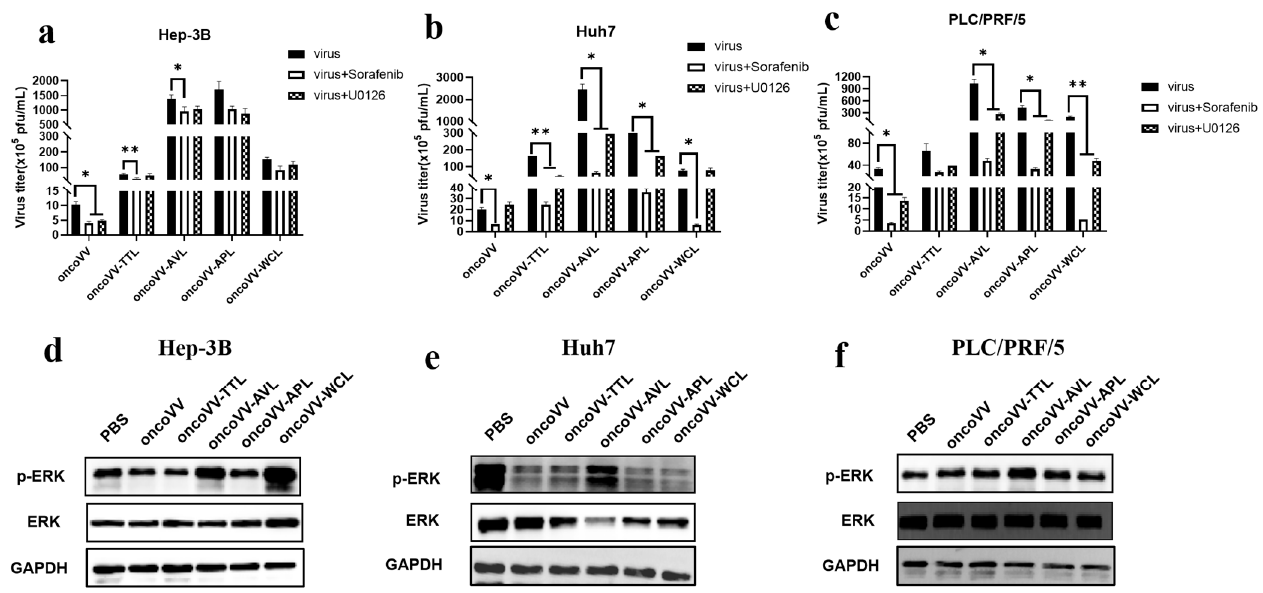
Figure 5. The effects of the ERK pathway on oncoVV-lectin replication in HCC. ( a – c ) Virus titers in the presence of Raf or MEK inhibitors (* p < 0.05, ** p < 0.01). Hep-3B, Huh7, and PLC/PRF/5 cells were maintained for 12 h and then treated with Sorafenib or U0126, followed by 5 MOI of recombinant virus infection about 1 h later. The above samples were collected at 36 h postinfection. Either 3 μ mol/L Sorafenib or 10 μ mol/L U0126 was used in Hep-3B cells; 10 μ mol/L Sorafenib or 10 μ mol/L U0126 was used in Huh7 and PLC/PRF/5 cells. ( d – f ) Expression levels of ERK and p-ERK determined by WB. Protein extracts after 36 h treatment were subjected to WB analysis for ERK and p-ERK. PBS and oncoVV served as the controls, and GAPDH was a loading control.